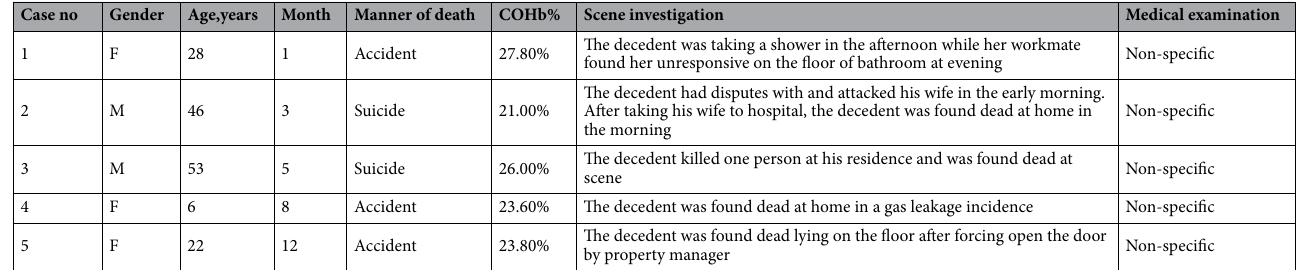
Table 6. Details of the 5 deaths with low COHb saturation and negative pathological findings. *Being non- specific denotes as no injury or macroscopic/microscopic